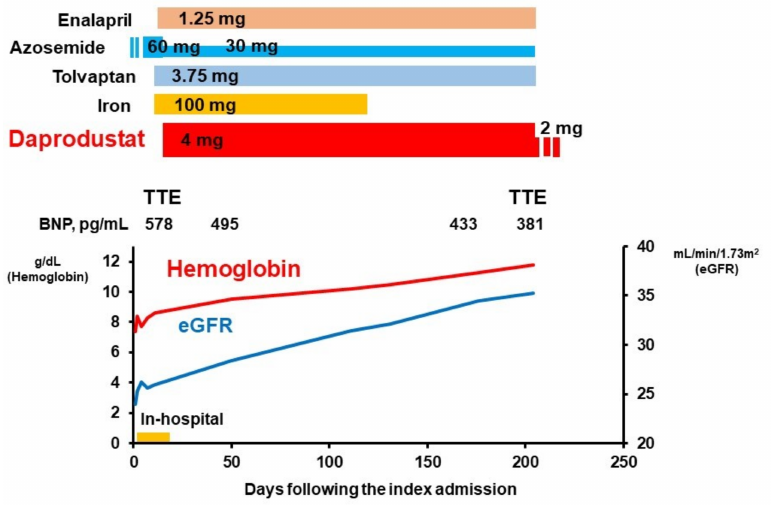
Figure 2. Eight-month time course following the index admission. TTE, transthoracic echocardiogra- phy; BNP, B-type natriuretic peptide; eGFR, estimated glomerular filtration ratio. Fecal occult blood test was negative. He further received gastrointestinal endoscopy, which found grade-A gastroesophageal reflux disease without no active bleeding. Proton pump inhibitor esomeprazole 20 mg/day was